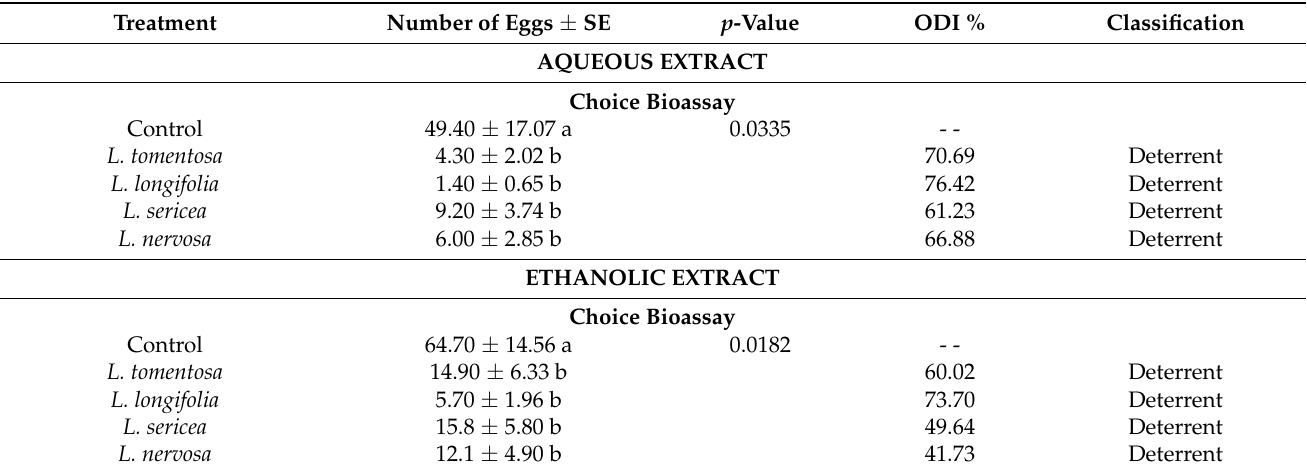
Table 2. Mean number of eggs oviposited by Plutella xylostella in the choice bioassays and the oviposition deterrent index (ODI) based on the use of aqueous and ethanolic extracts of Ludwigia